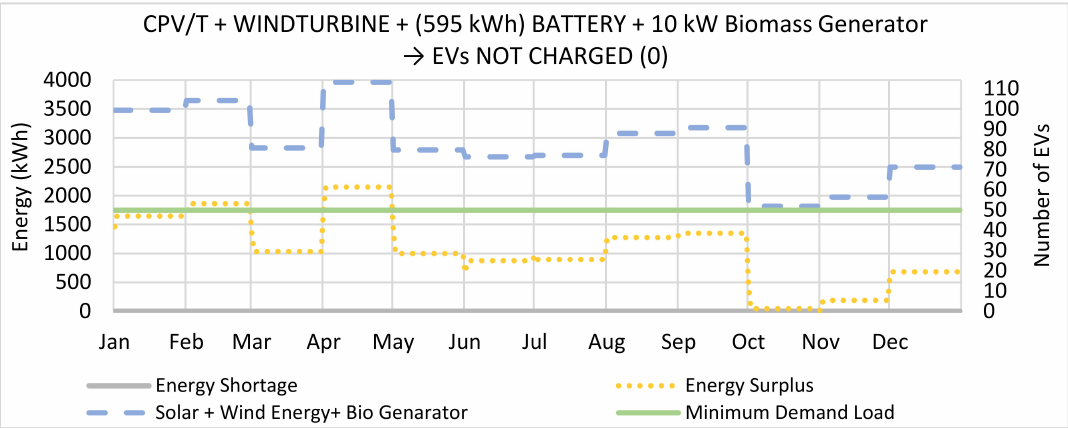
Figure 14. CPV / T, WT, biofuel power generator and adjusted BSS annual simulation.